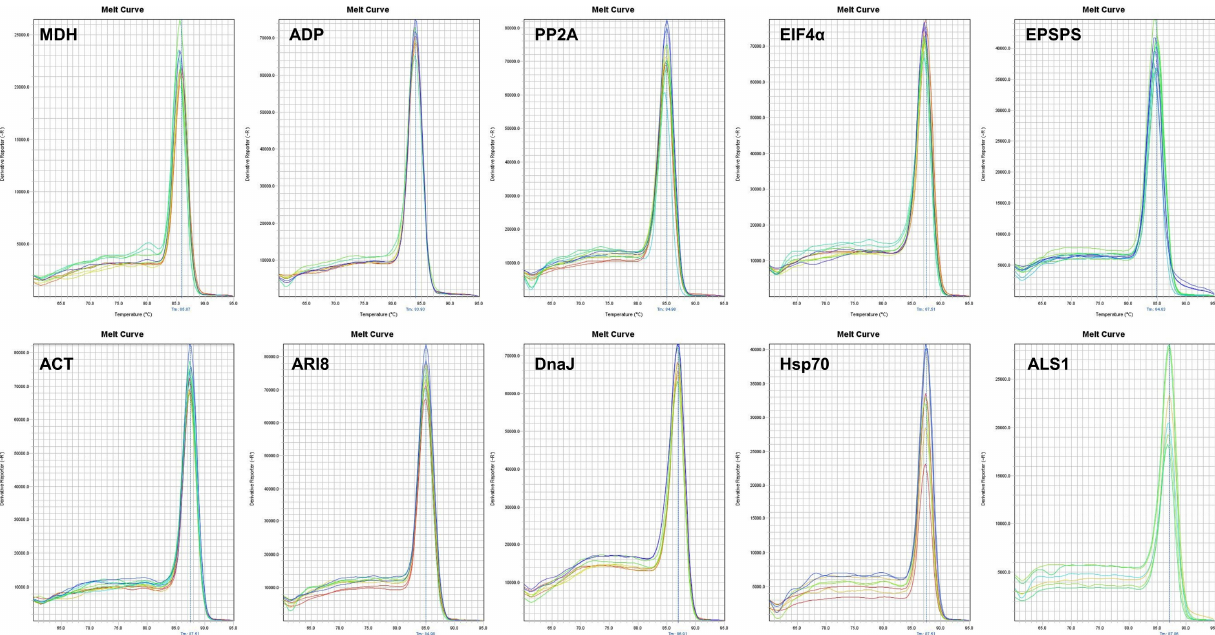
Figure 2. Dissociation curves of the nine reference genes evaluated and the EPSPS gene under experimental conditions, each showing a single peak. Table 1. Information on the primer pairs selected and amplification details. Slope: slope of standard curve; R 2 : correlation